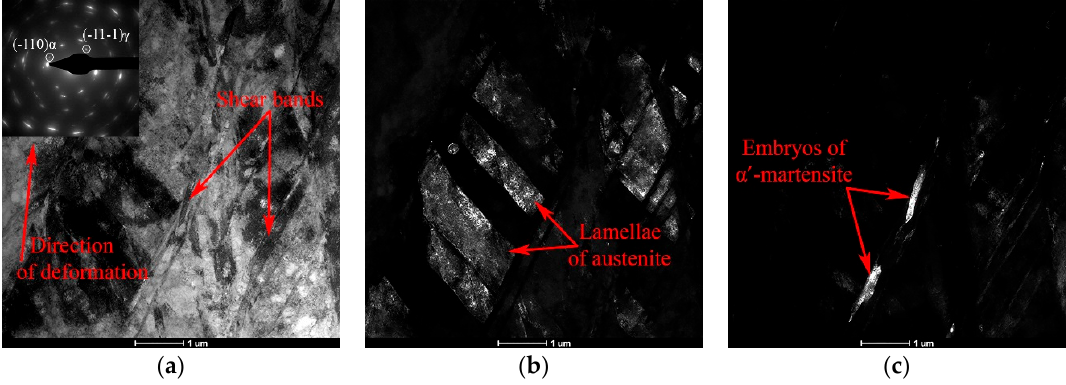
Figure 2. The TEM micrographs of the 321 MASS in the longitudinal section of the rod after deformation with the degree of e = 0.56: ( a ) Bright-field image; ( b , c ) Dark-field images from image ( a ) in reflections (–11–1) γ and (–110) α , respectively.